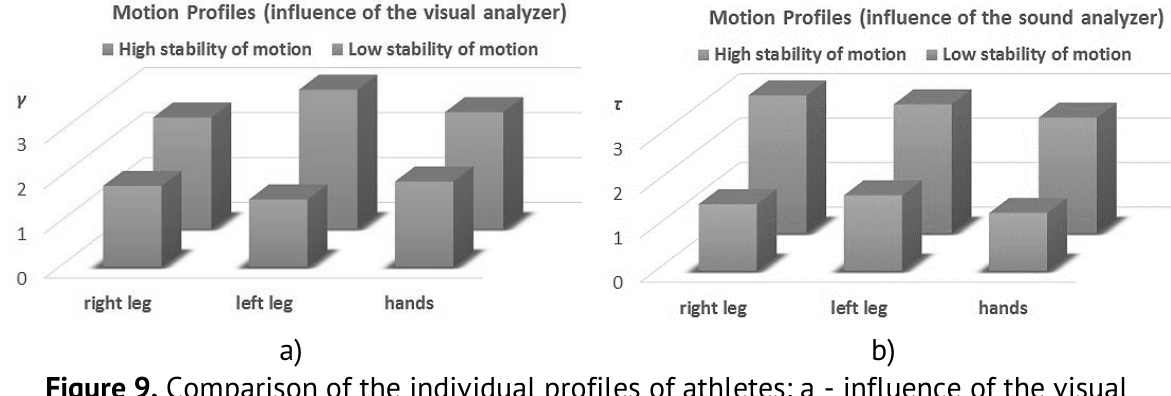
Figure 9. Comparison of the individual profiles of athletes: a - influence of the visual analyzer; b - influence of the sound